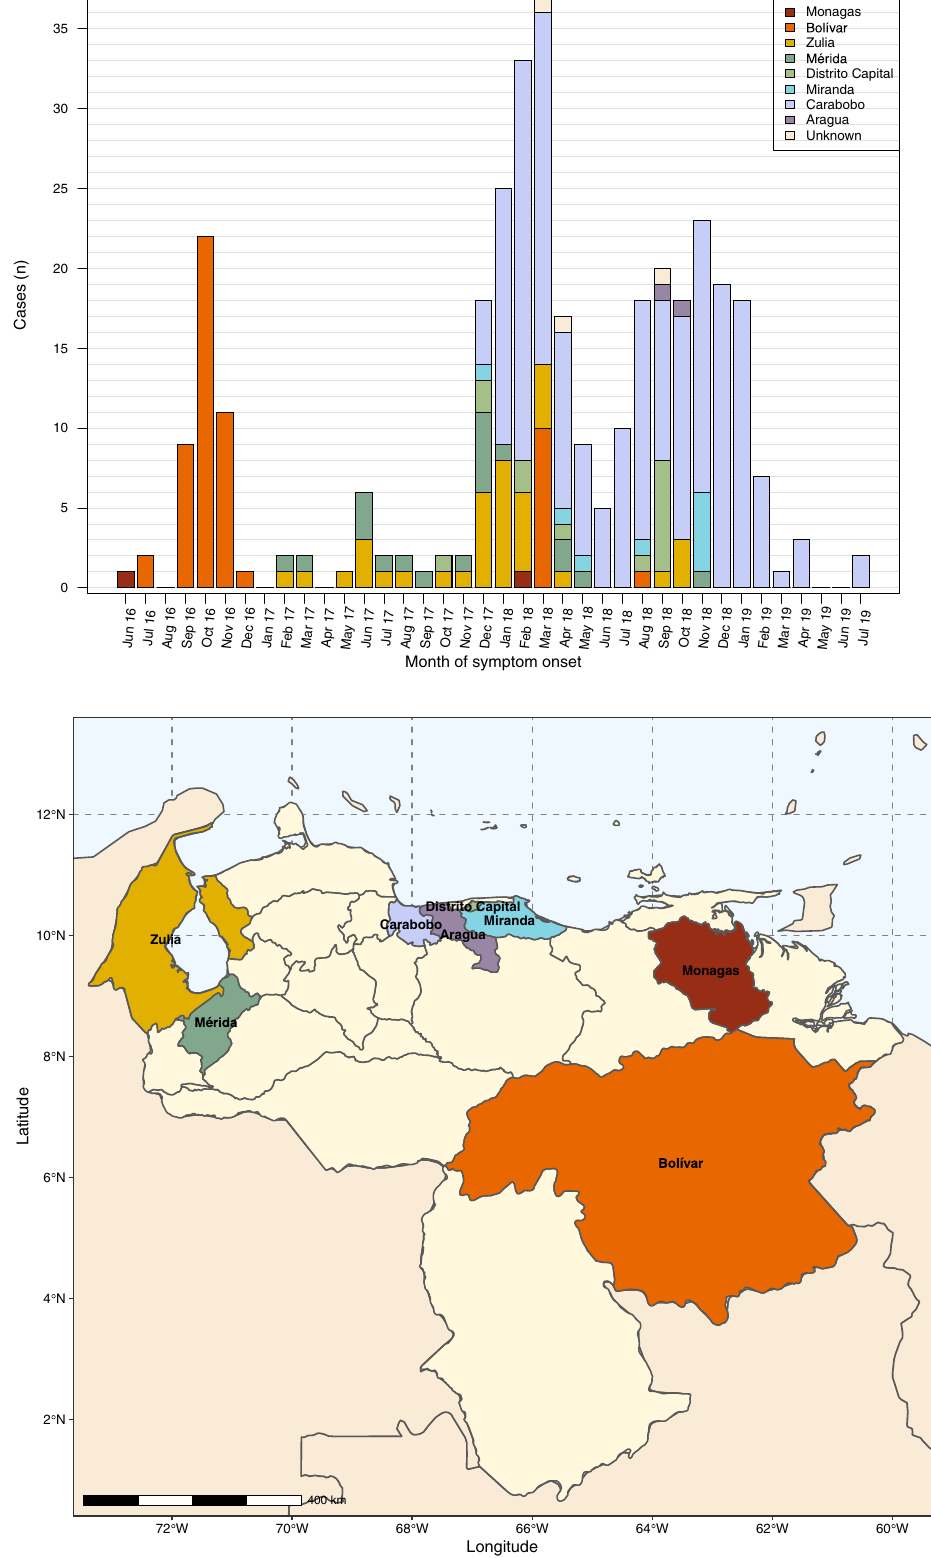
Figure 3. ( a ) Distribution of origin of diphtheria cases by epidemiological month of onset of symptoms, Venezuela, June 2016 and July 2019 (N = 349 of whom 346 had information on state available). (b) Map of Venezuela and affected